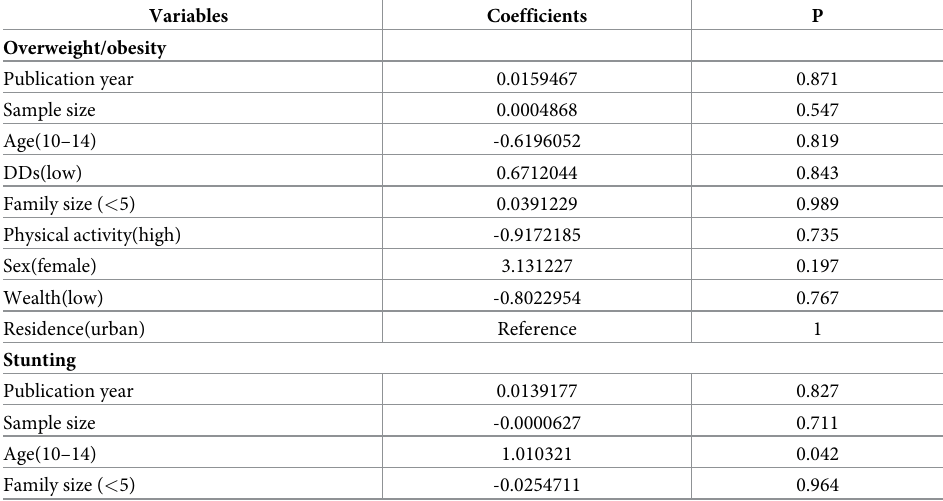
Table 7. Meta-regression to identify heterogeneity among factors associated with adolescent malnutrition in